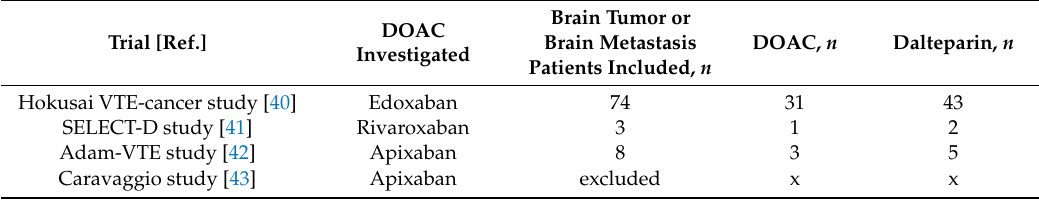
Abbreviations: Ref. =